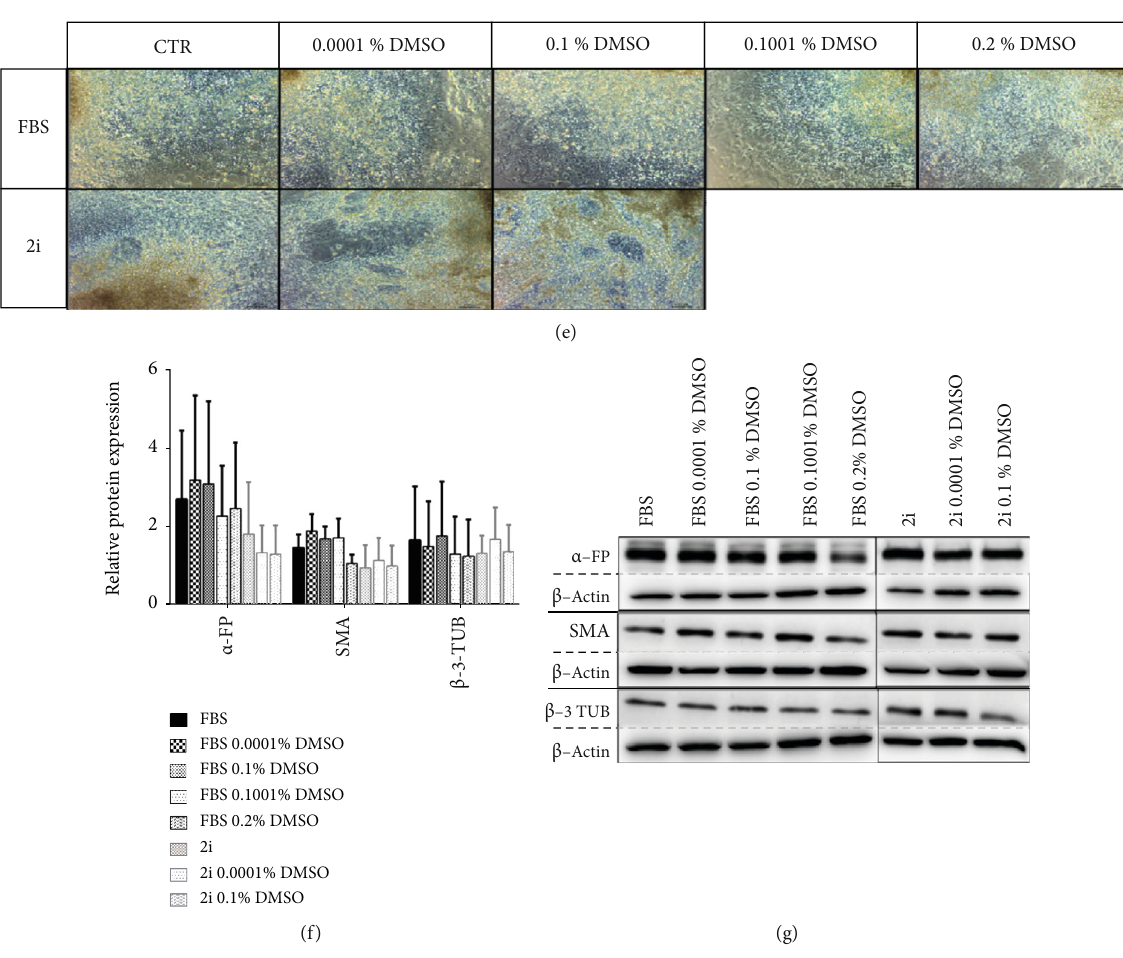
Figure 3: Exposure to small percentages of DMSO for 48 hours does not negatively a ff ect pluripotency marker expression or the di ff erentiation potential of mESC. (a) Representative immuno fl uorescence images of plated colonies presenting the pluripotency marker Nanog (red) and counterstained with Hoechst 33342 (blue) (600x magni fi cation) after a 48 h incubation with/without DMSO. (b) RT- PCR analysis for Oct4 , Nanog , Rexo1 , and Essrb mRNA gene expression normalized for endogenous beta-actin ( Actb ) at the 48 h time point. At least four independent experiments were performed, and the results are presented as means ± SEM . (c, d) Relative protein expression of the pluripotency factors Oct4 and Nanog evaluated by Western blot analysis and normalized by β -actin expression at